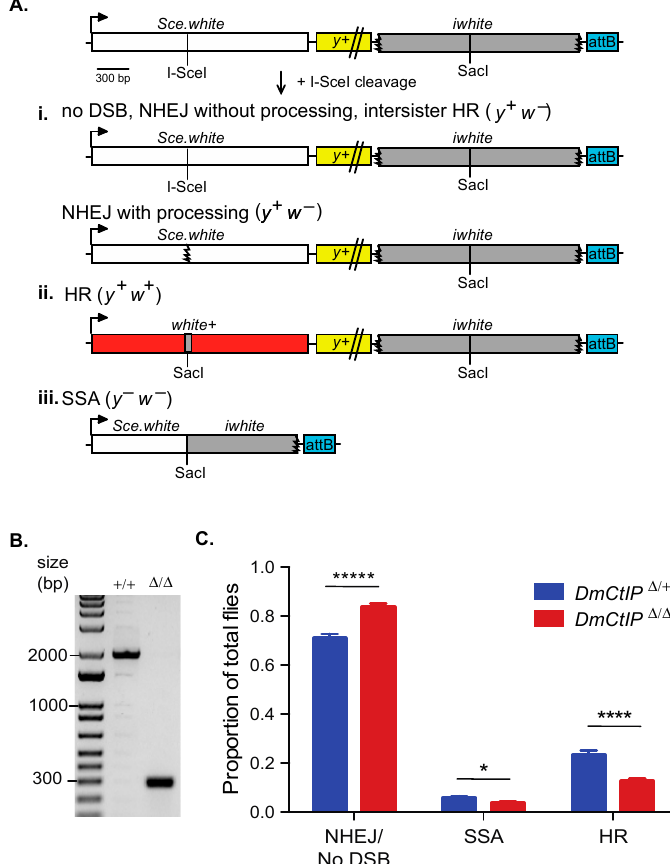
Figure 1 . DR- white assay suggests defects in homologous recombination in DmCtIP ∆ / ∆ mutants. ( A ) The direct repeat of white (DR- white ) assay contains two non-functional white repeats: Sce.white (I-SceI recognition site and premature STOP codon) and iwhite (truncated donor sequence). DR- white is integrated into the genome at Chromosome 2 at a known attP landing site using the attB sequence (blue) and followed using the yellow ( y + ) transgene. Embryos and larvae containing DR- white and the heat-shock inducible I-SceI transgene are heat shocked, and a DSB is formed at the I-SceI site. Repair events are observed by crossing single males to y w tester females. The resulting progeny are representative of single double-strand break (DSB) repair events from the premeiotic male germline. Depending on the repair pathway, one of three phenotypes will result. (i) White-eyed progeny ( y + w – ) are indicative of no DSB, intersister homologous recombination (HR), or non-homologous end joining (NHEJ). NHEJ with processing can be determined through molecular analysis. (ii) Red-eyed progeny ( y + w + ) indicate repair by intrachromosomal HR with the iwhite sequence as the donor, restoring the function of the white gene. (iii) Yellow-bodied, white-eyed progeny ( y – w – ) indicate repair by single-strand annealing (SSA), a mitotic crossover event (indistinguishable from SSA), or an abnormal repair event that inhibits y + expression, such as a deletion into the y + transgene. ( B ) PCR amplification across the CRISPR/Cas9-mediated deletion of DmCtIP . Primers produce 1934 bp product in wildtype (+/+) and 283 bp product in DmCtIP ∆ / ∆ mutants ( ∆ / ∆ ) ( C ) I-SceI-induced DSB repair events in a D. melanogaster C-terminal Binding Protein 1 Interacting Protein ( DmCtIP ∆ / ∆ ) mutant background (red; n = 28 germlines, 1520 total flies scored) compared to DmCtIP ∆ /+ heterozygote controls (blue; n = 28 germlines, 1289 total flies scored). Results shown are averages ± standard error of the mean (S.E.M.) of individual male germline events. * p < 0.05, **** p < 0.0001, and ***** p < 0.00001 by unpaired Student’s t